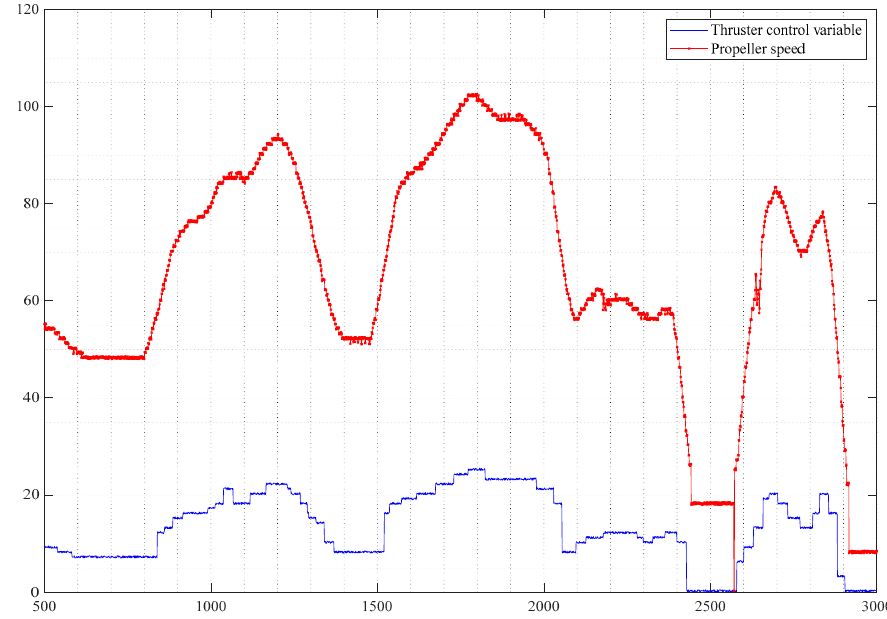
Figure 17. Thruster control variable and propeller speed of the portable AUV.